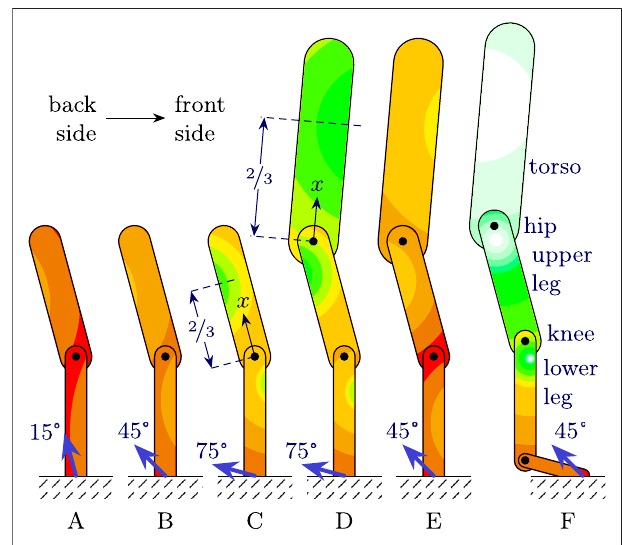
FIGURE2| Typicalshockscenariosofastep made witha robot leg that could be part ofa humanoid or human with prosthesis (A: walking, B: running, C: stair climbing). Shock is shown to be less in certain areas of the robot,